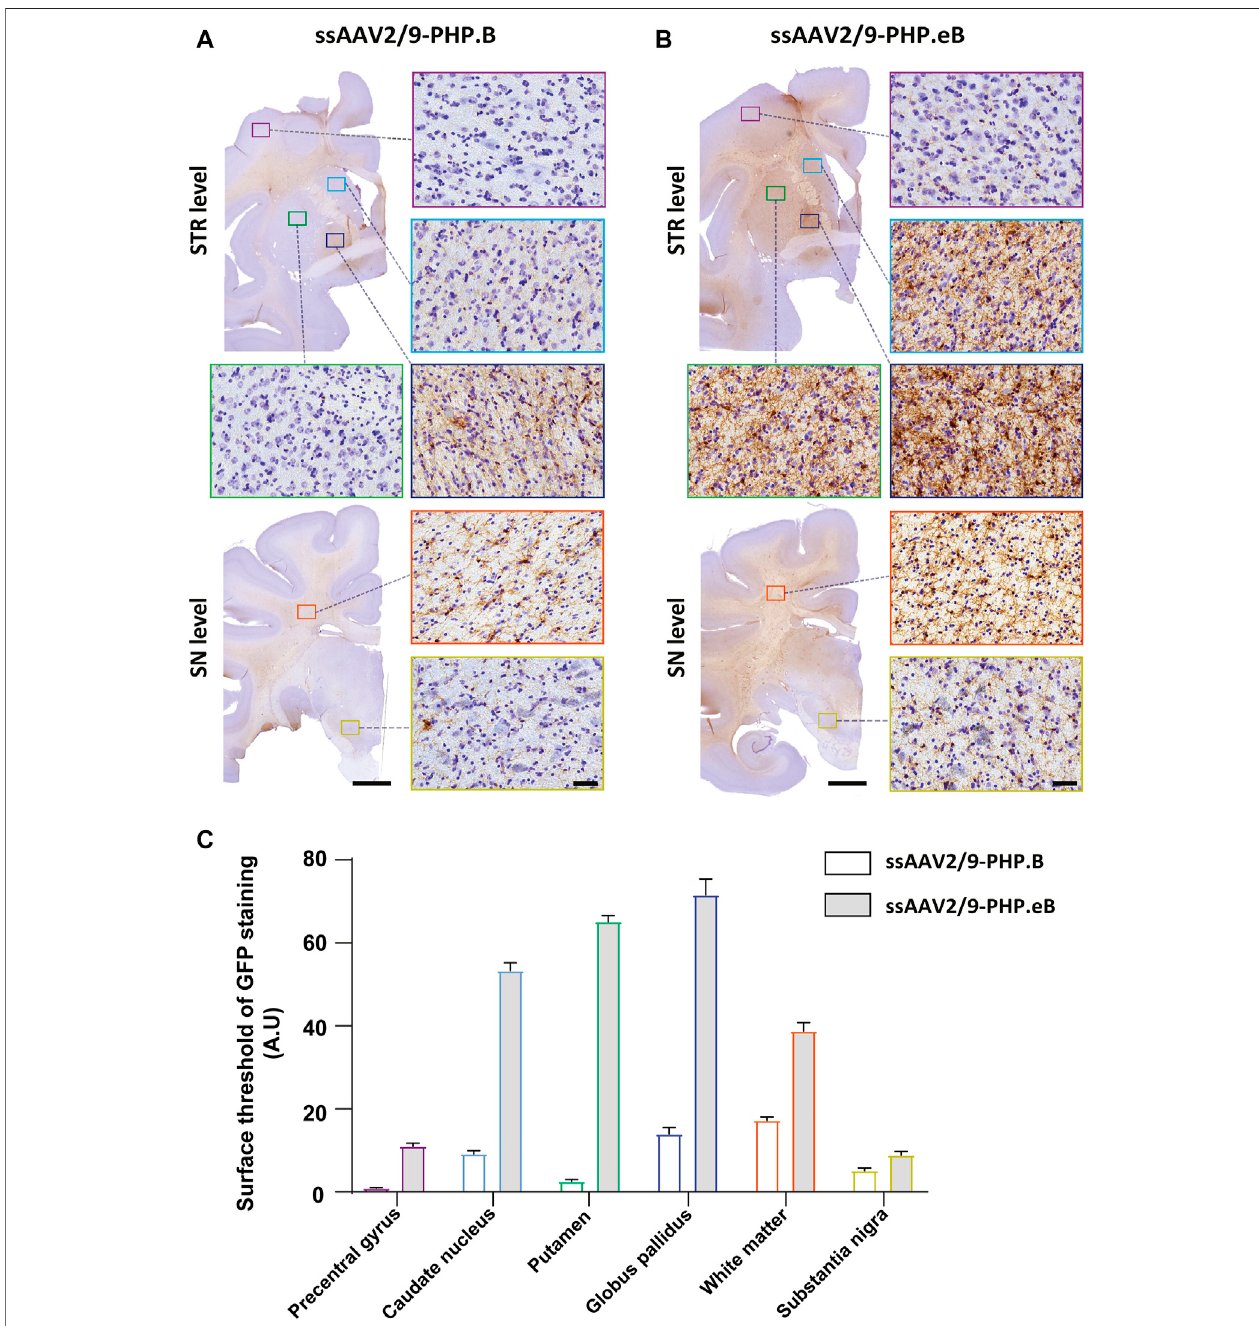
FIGURE 1 | Stronger widespread brain EGFP distribution after intrathecal injection of AAV-PHP. eB compared to variants AAV-PHP. B in non-human primates. (A – B) Representative coronal brain sections at two different rostrocaudal levels (top, “ STR ” (cid:2) striatal level, AC0; bottom, “ SN ” (cid:2) Substantia Nigra level, AC-8) of EGFP immunostaining (left) and illustrative photomicrographs (right) of EGFP immunostainingin the precentral gyrus (purple square), in the caudate nucleus (light blue square), in the putamen (green square), in the globus pallidus (dark blue square), in the white matter (orange square) and the substantia nigra (yellow square) in monkeys injected with either AAV-PHP. B (A) or AAV-PHP. eB (B) . Scale bars (cid:2) 5 mm (left, sections) and 40 µm (right, insets). (C) Quantitative analysis of GFP immunostaining measured by the surface threshold in all analyzed regions, including the precentral gyrus, the caudate nucleus, the putamen, the globus pallidus, the white matter, and the substantia nigra in AAV-injected monkeys. Data represent mean ± SEM.